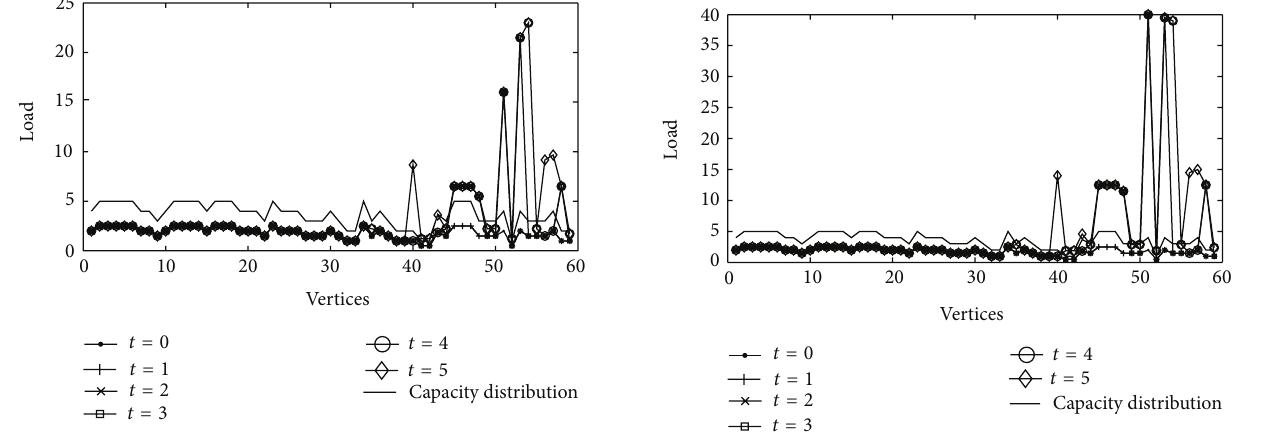
Figure 8: Load distributions of the evolution process in Case